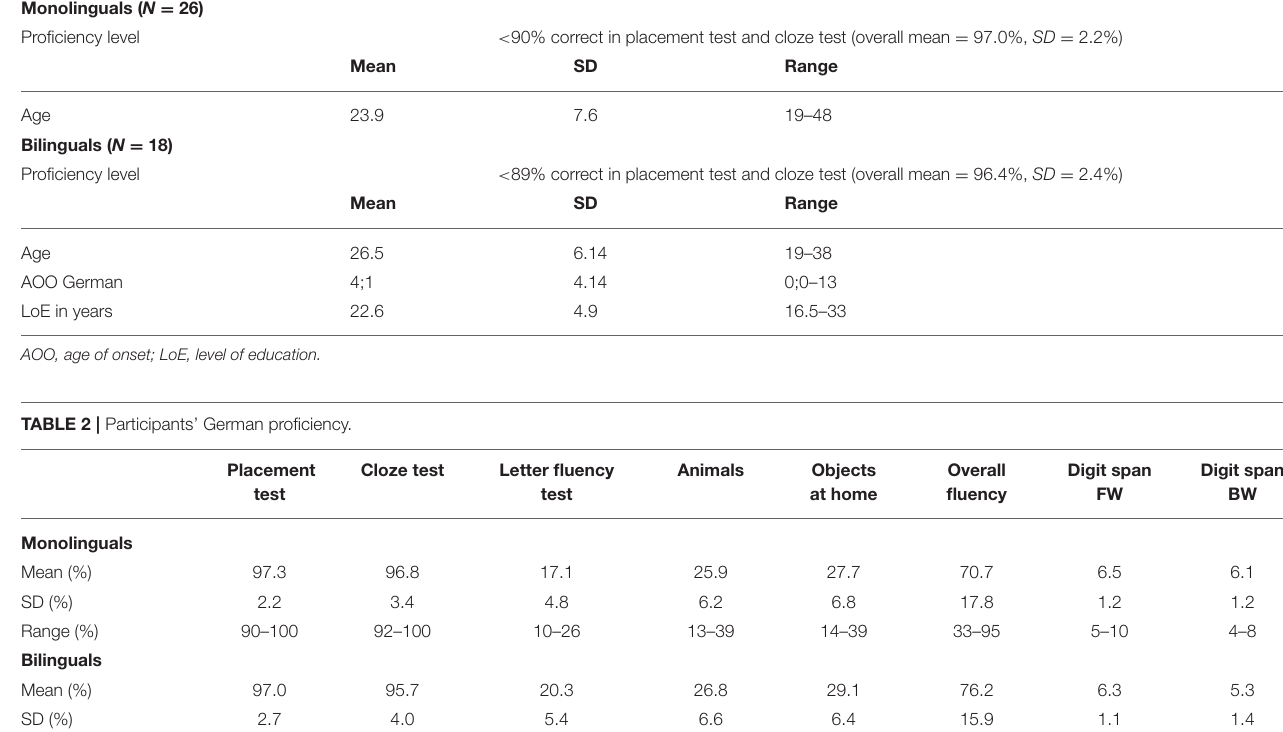
TABLE 1 | Participants’ characteristics.